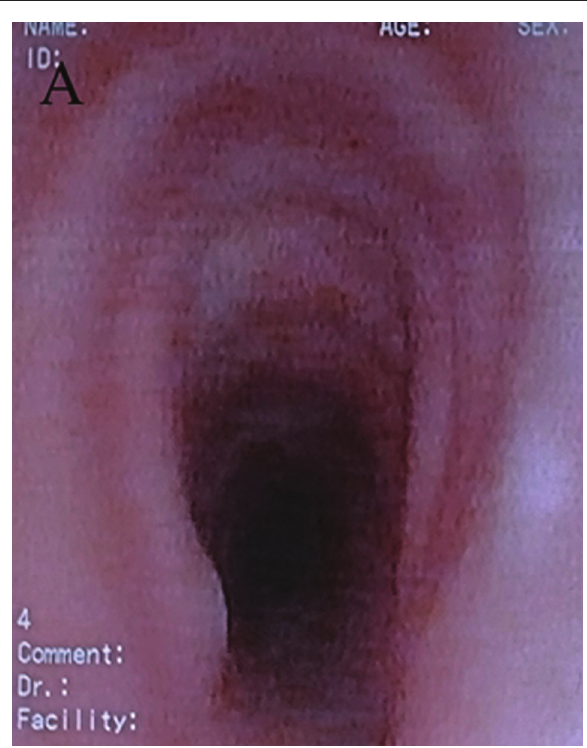
Fiber-optic bronchoscopic image showing scabbard